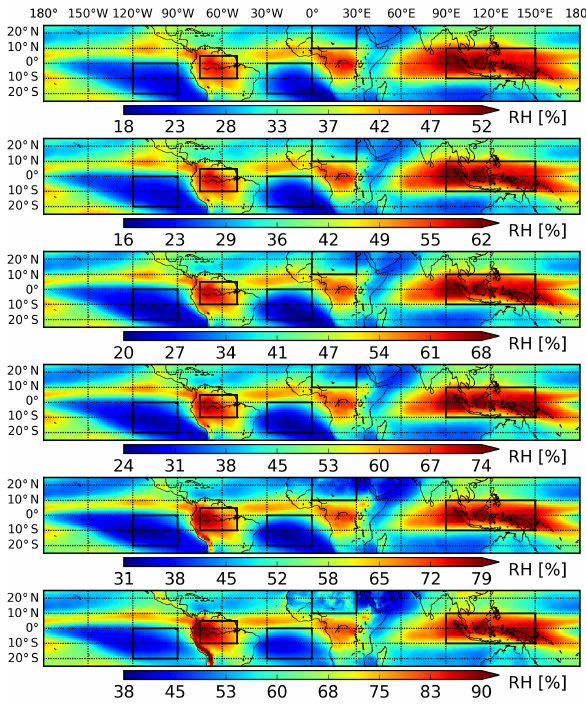
Figure 6. Spatial distribution of layer-averaged RH L derived using SAPHIR data for the period January 2012 to September 2015. De- picts from top to bottom are for SAPHIR channels 1–6, respectively.